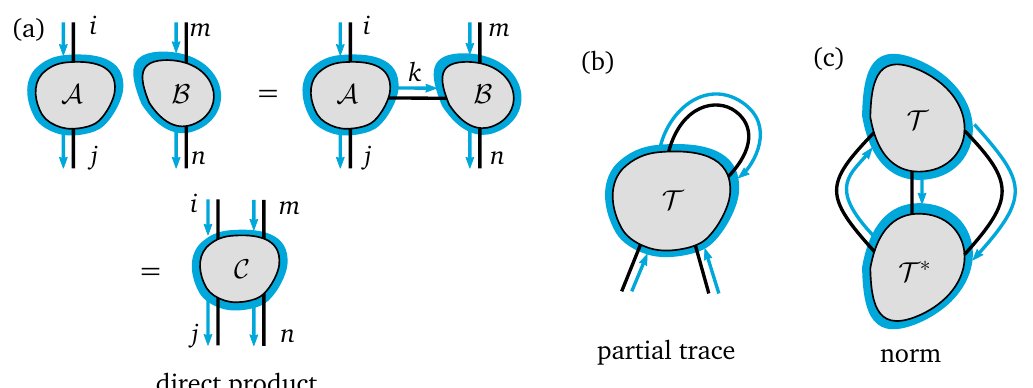
Figure 22: Variants of contractions (compare Sec. 2.2.2 and Fig. 8), now cast into a symmetric form: (a) Direct product. Between any two tensors, a dummy link can be inserted to indicate a contraction. With symmetric tensors, such intermediate product links may acquire a deeper meaning as quantum-number “transfer links” if they carry a non-degenerate quantum number (cid:96) (cid:54) = 0. A typical application is the correlation function c † ⊗ c of particle creation and annihilation operators c † and c under a U ( 1 ) particle-conservation symmetry, which might, for example, occur in a Hubbard model. In this context, the transfer link carries a single quantum number (cid:96) = + 1 or (cid:96) = − 1 (depending on the direction of the link) which accounts for the particle hopping associated with the operation c † ⊗ c . Contracting the (covariant) tensors representing the two operators over the intermediate link yields again a symmetric invariant tensor. (b) Partial trace, which can be carried out as a contraction over pairs of similar, oppositely directed symmetric links at the same tensor. (c) Hilbert–Schmidt norm, performed as contraction with the hermitian conjugate T † which extends the complex conjugation by the simultaneous inversion of all